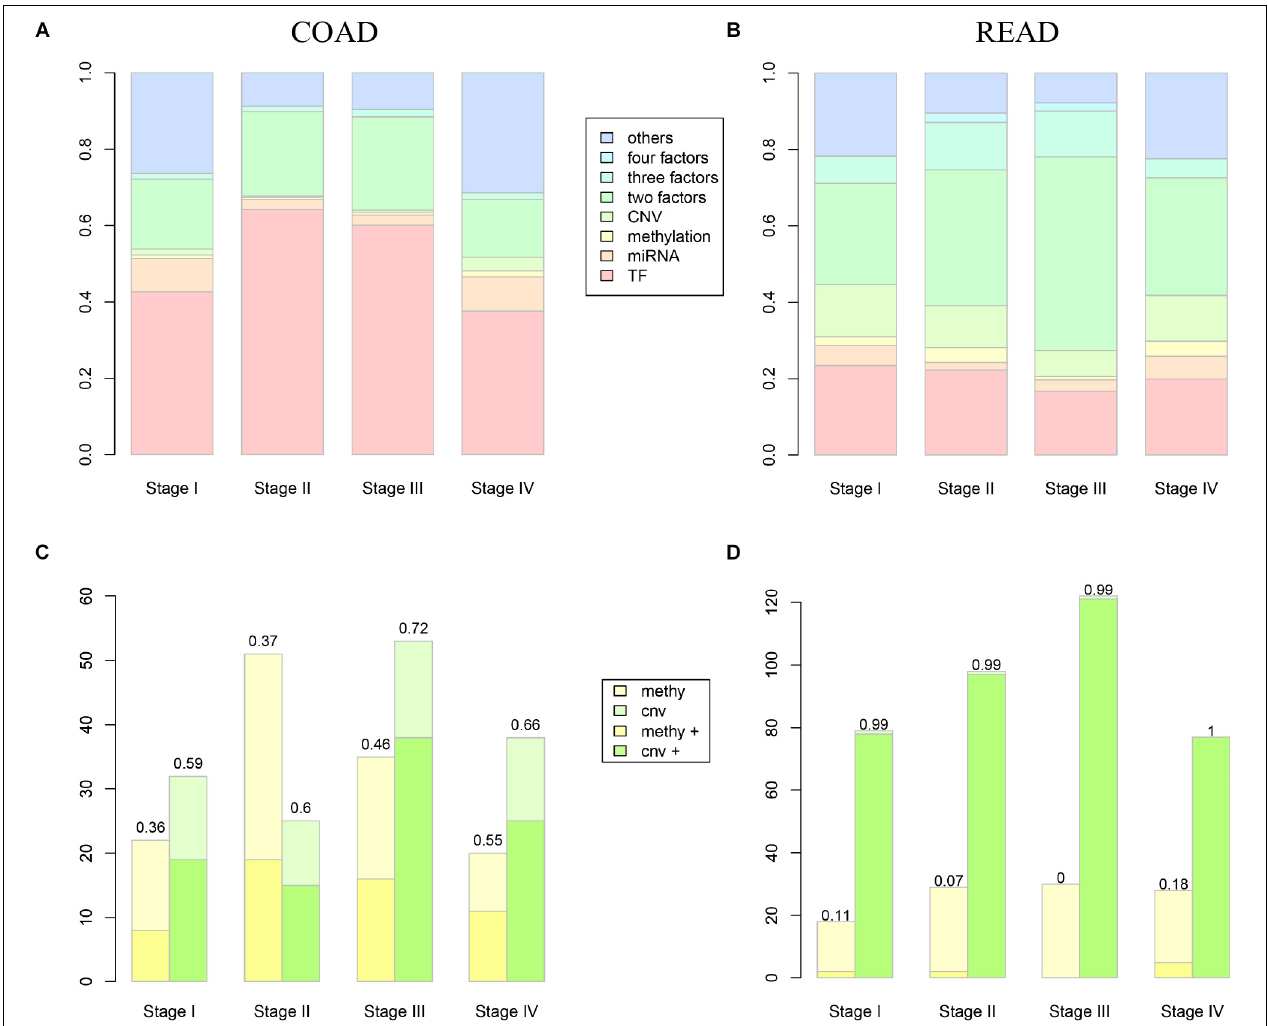
FIGURE 3 | The influence of different level factors. (A,B) Show the proportion of DEAGs regulated by CNVs, methylation, miRNAs, TFs, and composite factors in COAD and READ respectively. (C,D) Show the influence of methylation and CNV to DEAGs in COAD and READ respectively. Yellow boxes represent the number of autophagy genes influenced by methylation, while green boxes represent the number of autophagy genes influenced by CNVs. The lighter color represents negative regulation, and the deeper color represents positive